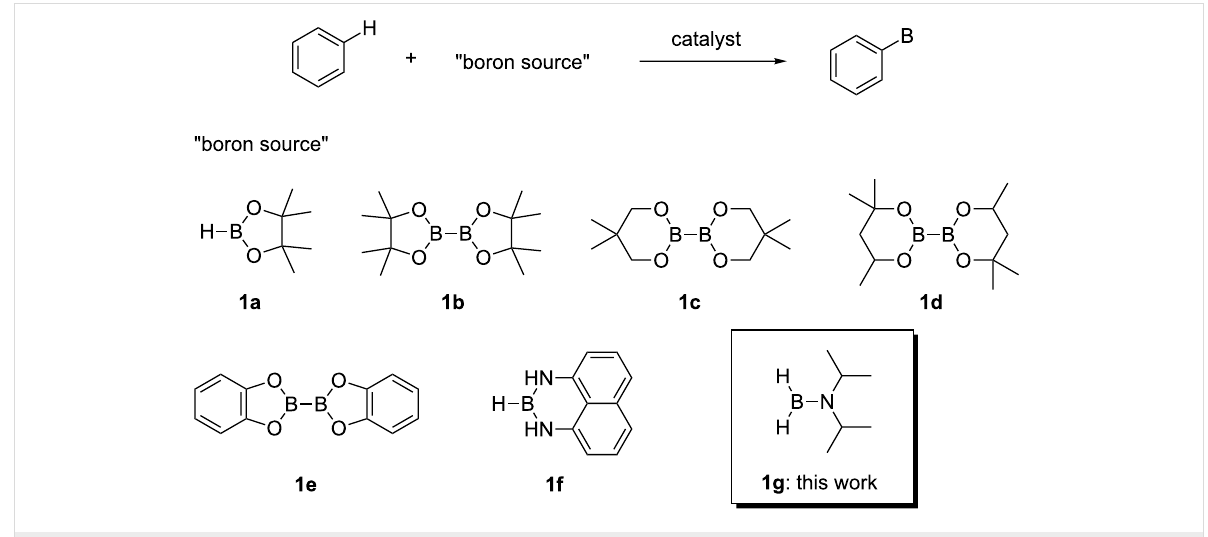
Scheme 1: Catalytic C–H borylation of arenes and related reported boron sources.